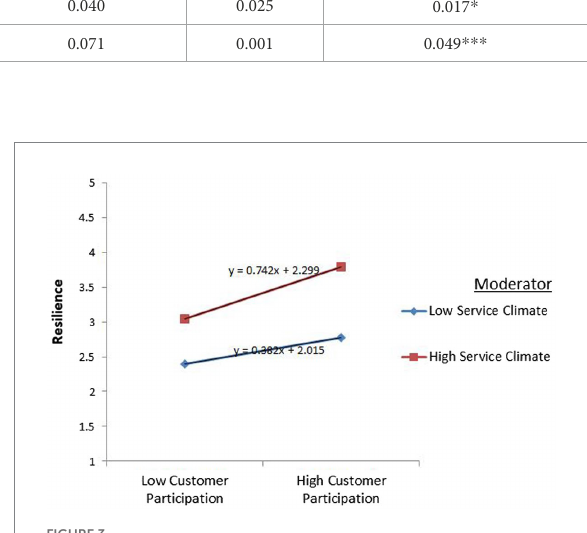
FIGURE 2 Service climate strengthens the relationship between customer participation and customer value co-creation.